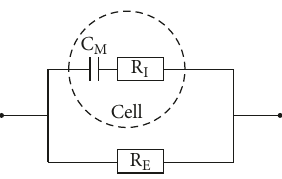
Figure 1: Model representing the electrical properties of body tissue [21]. R E corresponds to the electrical resistance offered by the extracellular water (ECW) and likewise R I from the intracellular water (ICW). C M represents (at the body level) cell membrane capacitance of the double-layered cell membrane, i.e., the cell’s ability to uphold a charge difference between the two sides of the membrane. The BIS device applies an alternating current (AC) and measures the combined impedance. Due to C M , the impedance will depend on the frequency of the electrical current, because high- frequency currents pass the cell membrane with less opposition than low-frequency currents. R E and R I are measured in Ohm ( Ω ), while C M is measured in nanofarad